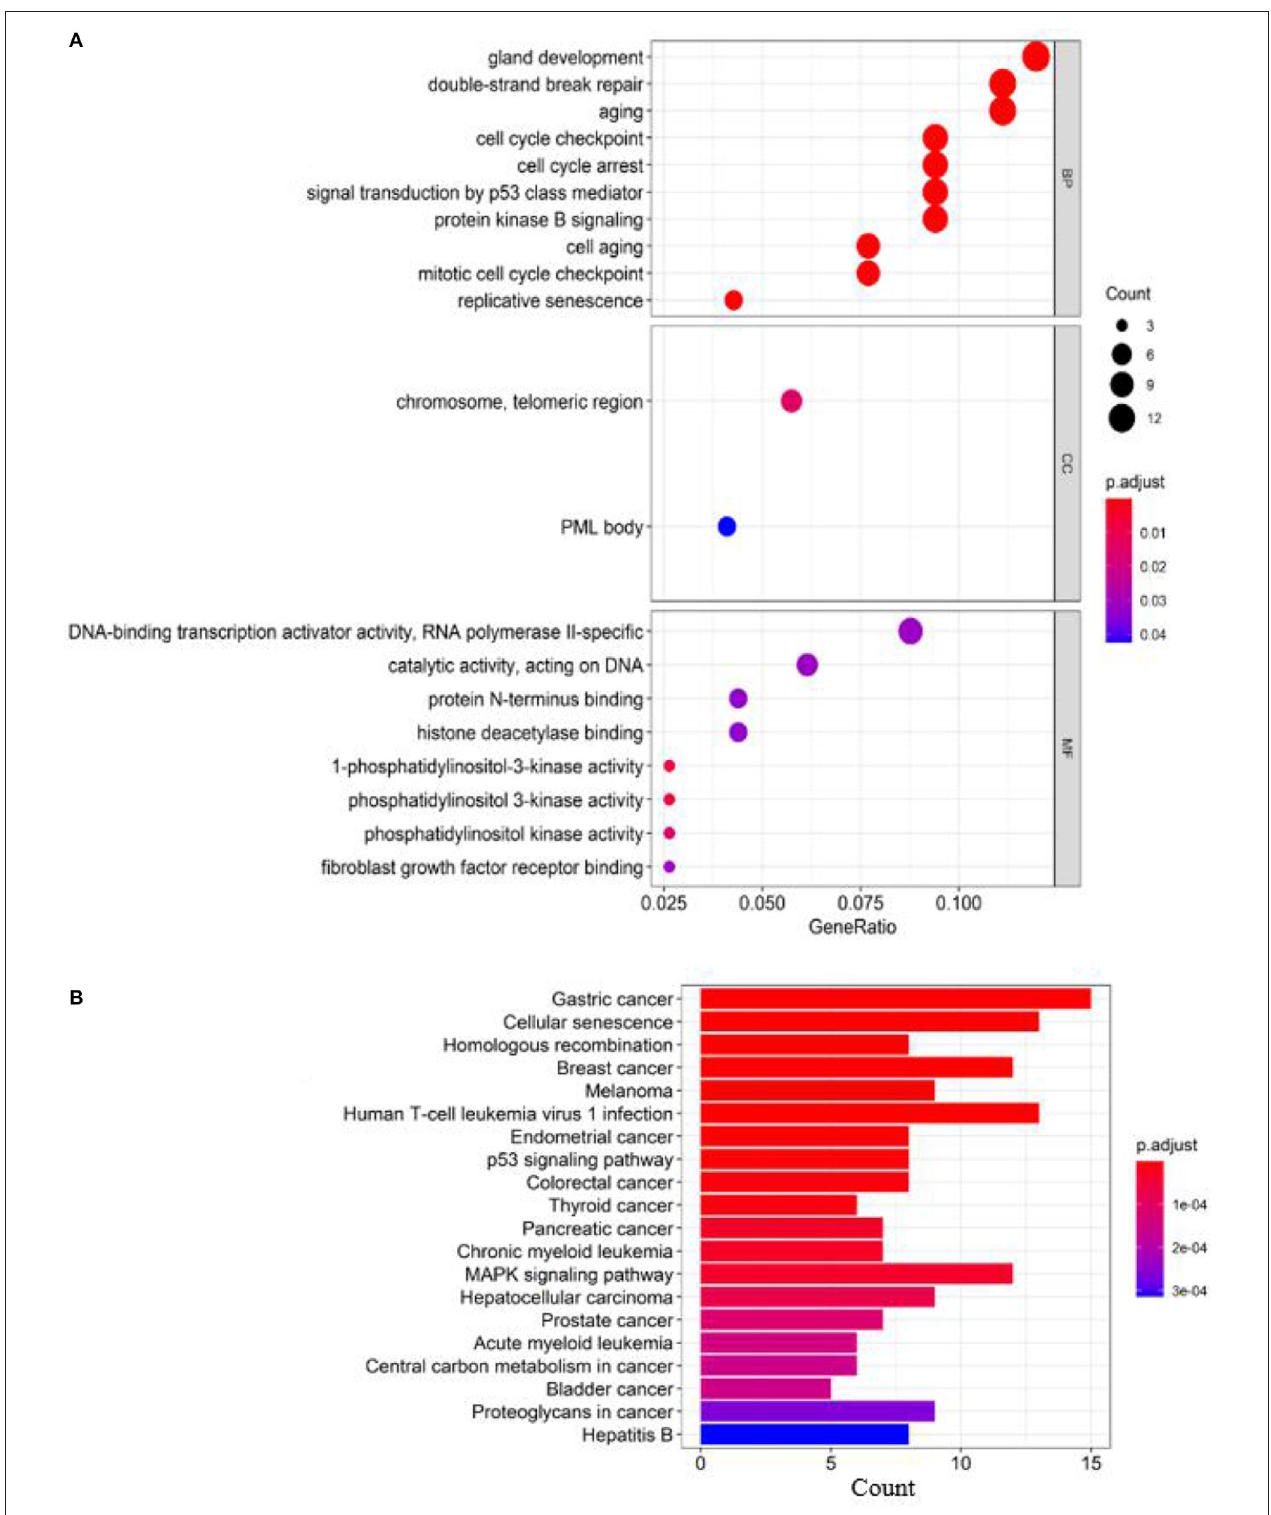
FIGURE 3 | Enrichment analysis of known breast cancer–related genes: (A) GO enrichment analysis and (B) pathway enrichment analysis.